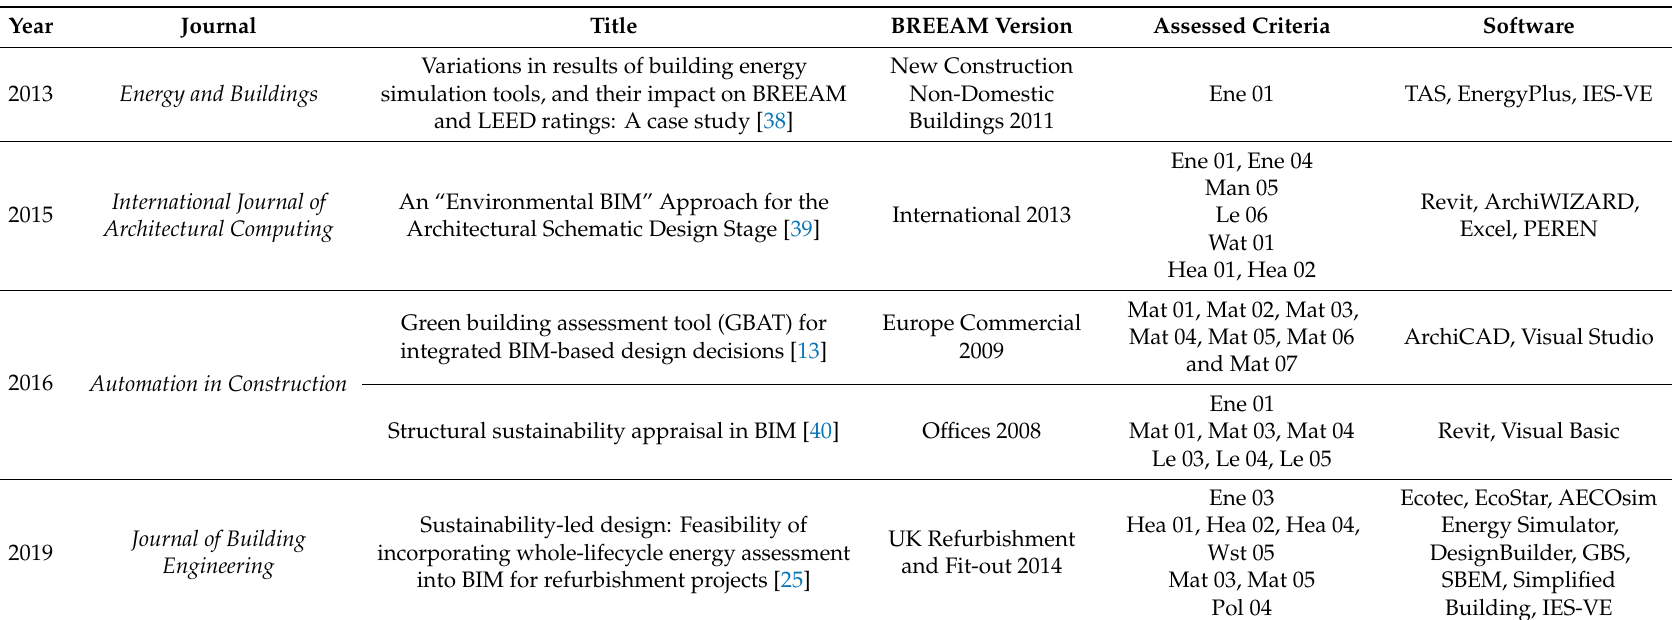
Table 2. BIM integration on